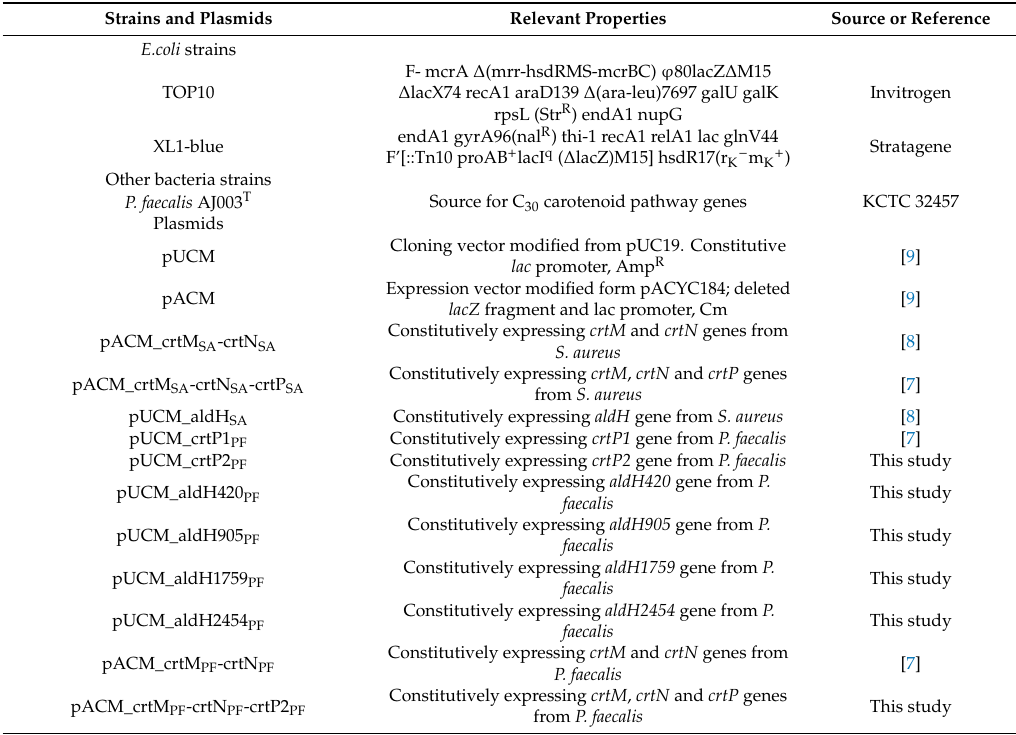
Table 1. Strains and plasmids used in this